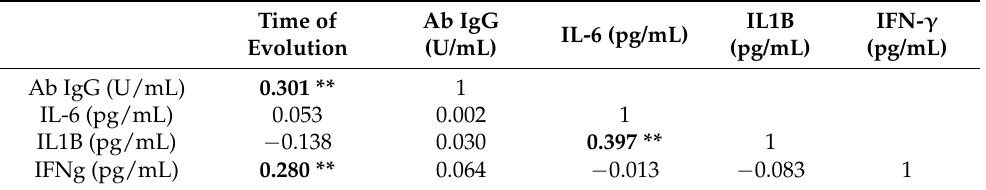
Table 5. Umbilical cord blood samples. Correlations between cytokines concentrations. Pearson’s coefficient. Pearson’s significant correlation coefficients have been highlighted.